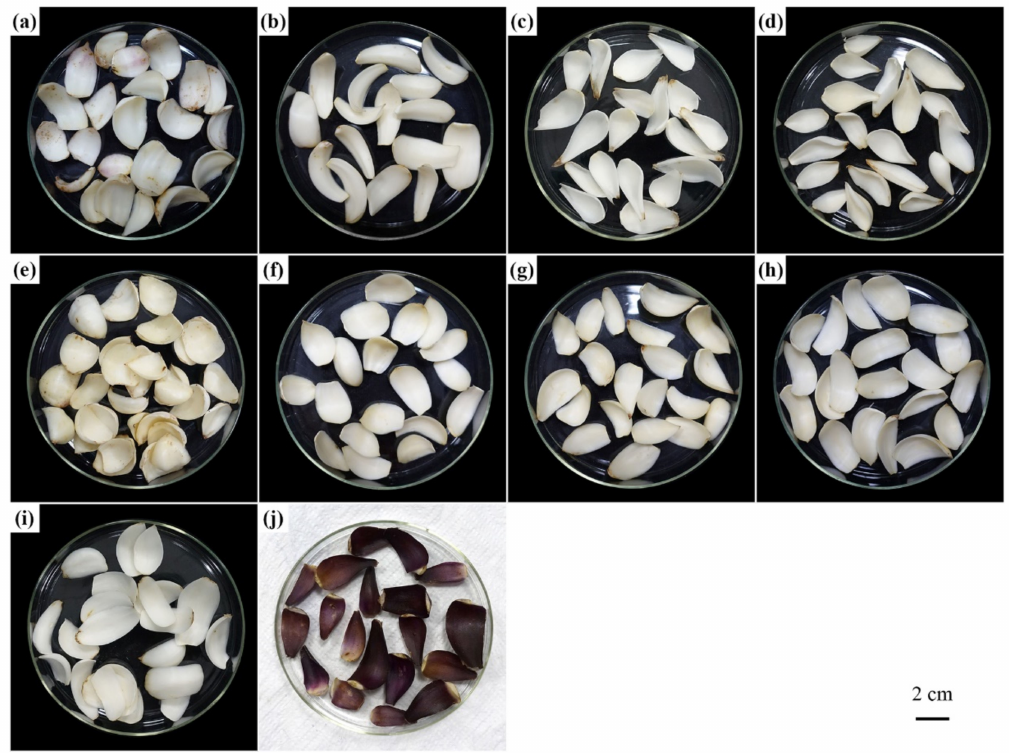
Figure 6. Photos of ten Lilium bulb samples belonging to five different species. ( a ) LY-WZ; ( b ) LY-YZ; ( c ) SD-CD; ( d ) SD-YA; ( e ) JD-AB; ( f ) JD-LS; ( g ) JD-MSH; ( h ) JD-YX; ( i ) LZ; ( j )